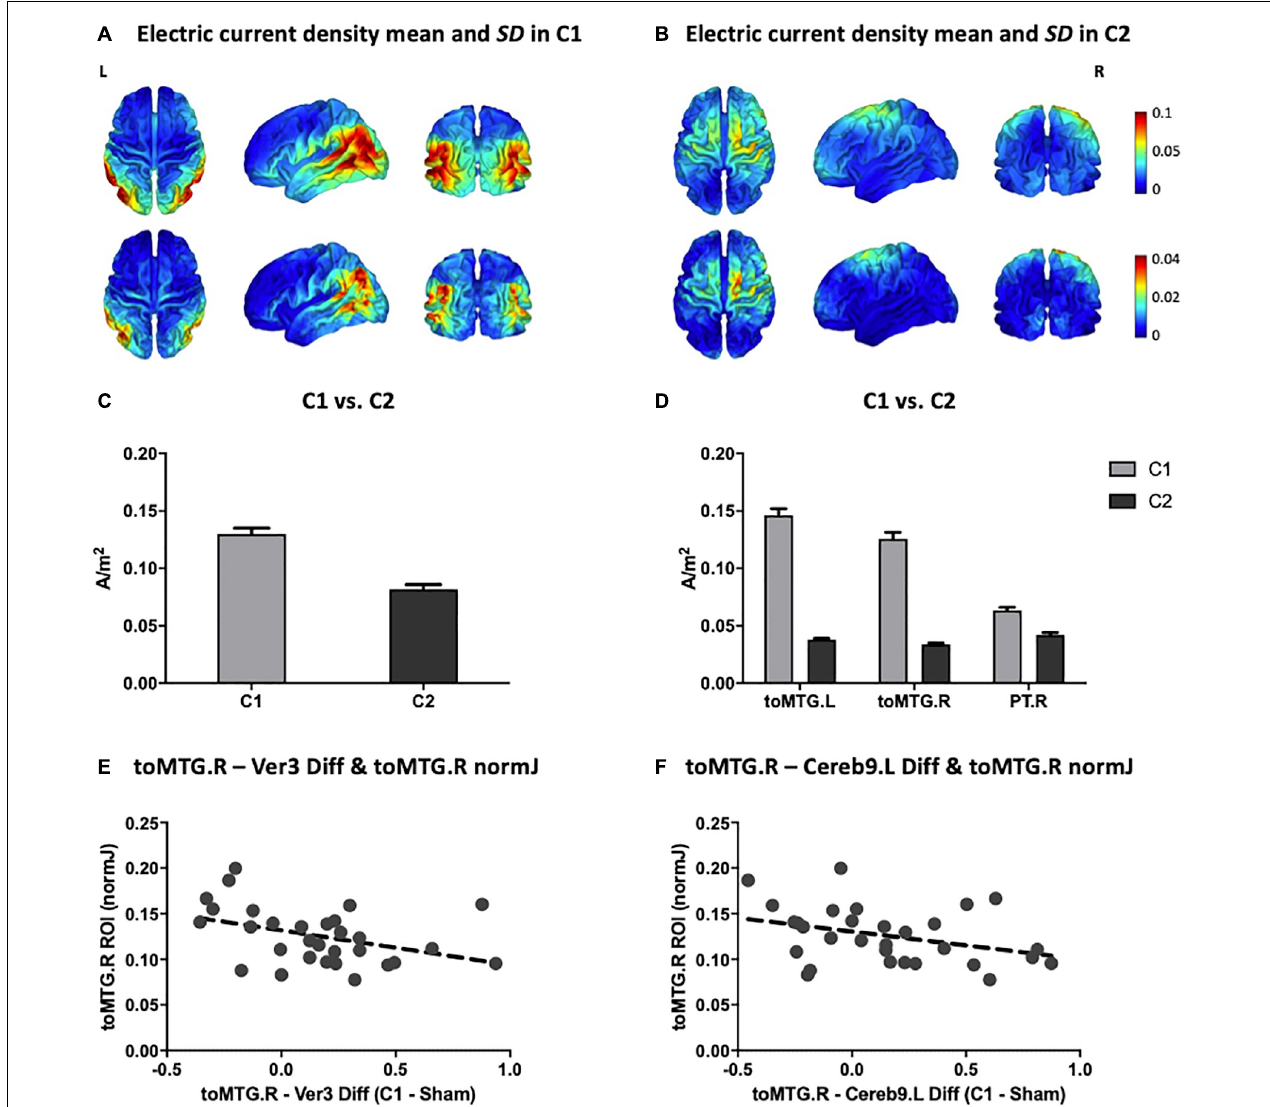
FIGURE 4 | Multifocal tDCS simulated electric current distributions. Anatomical pattern of the electric current density mean (top) and SD (bottom) for all subjects in (A) C1 and (B) C2 (in A/m 2 units). (C) Comparison between C1 and C2 of the mean magnitude of the peak fields (99.9th percentile; in A/m 2 units). (D) Comparison between C1 and C2 of the electric current magnitude extracted from the three main hubs detected on the rs-fMRI analyses (i.e., toMTG.L, toMTG.R and PT.R; in A/m 2 units). (E,F) Scatter plots showing the associations between multifocal tDCS-induced changes in rs-fMRI connectivity estimates and electric current magnitude values (in A/m 2 units). Data in (C,D) are presented with mean with SEM . C1, condition 1; C2, condition 2; toMTG, Middle temporal gyrus, temporo-occipital part; PT, Planum temporale; Ver, Vermis; Cereb, Cerebellum; L, left; R, right; Diff,